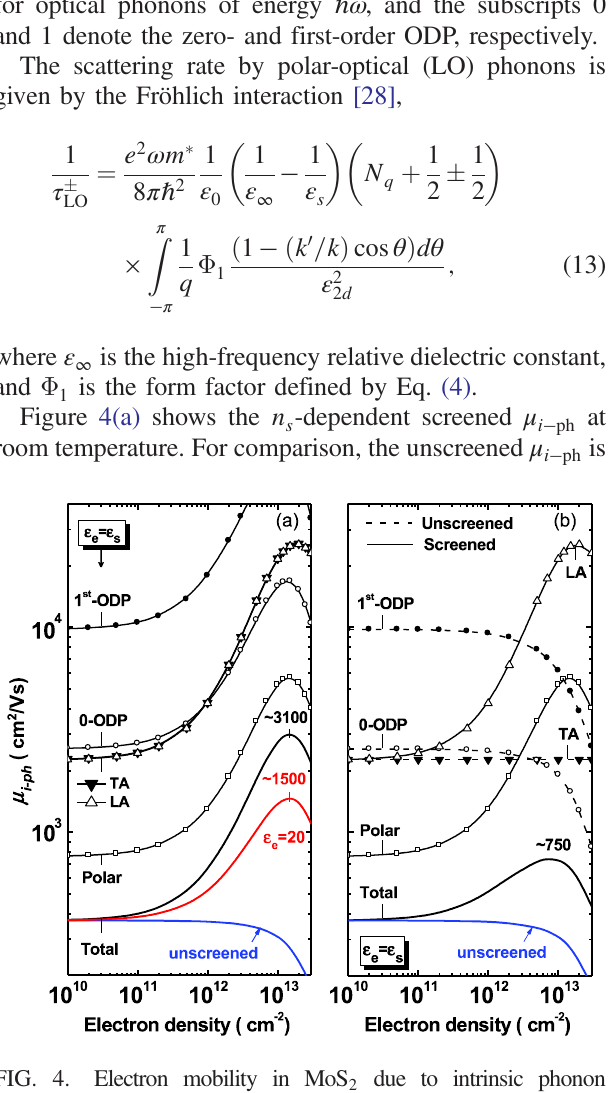
FIG. 4. Electron mobility in MoS 2 due to intrinsic phonon scattering at room temperature with the electron-phonon interaction (a) fully screened and (b) partially screened. The dashed lines show mobilities limited by unscreened phonon modes, and the solid lines show the mobilities limited by fully screened